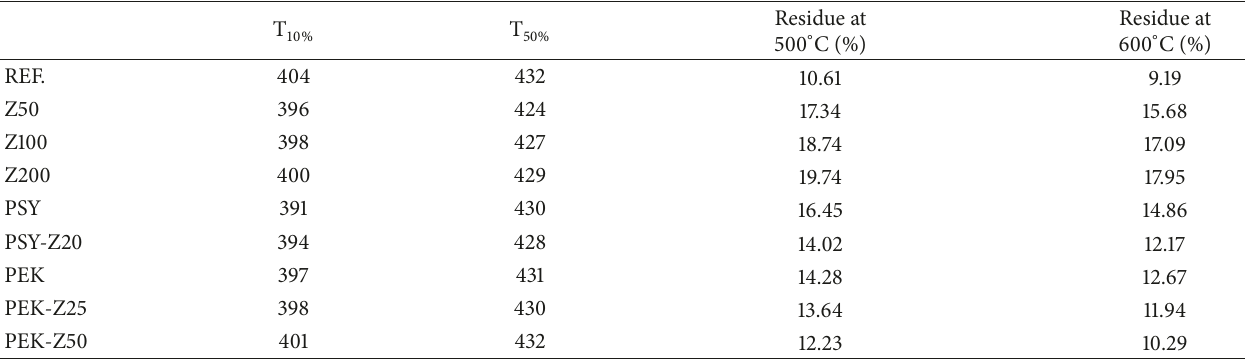
Figure 1: (a) Particle size distribution and (b) zeta potential plots of ZnB milled by using sodium citrate and sodium sulfate. Table 4: TGA test results of the